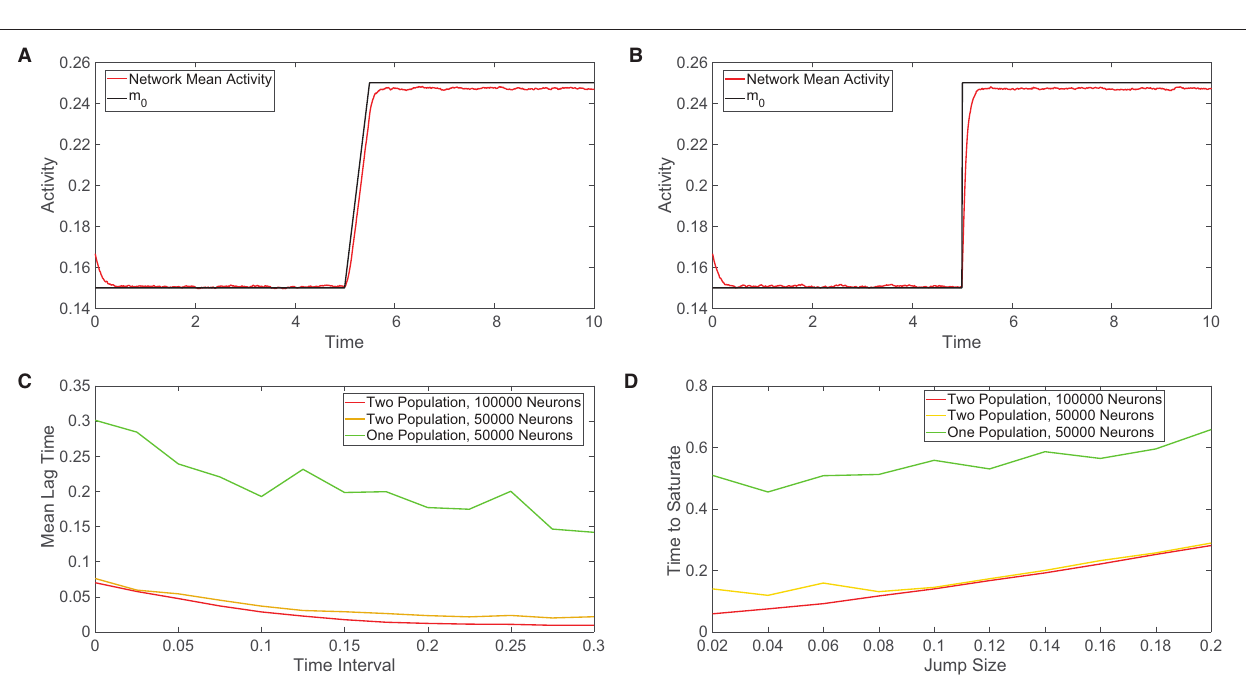
FIGURE 4 | and inhibitory inputs across each network model as a function of network size. (C) Variance of the ratio between time-averaged excitatory and inhibitory inputs across each network model as a function of network size. Parameters in the one-population network utilized are J E 1, J I 1.5, m 0 0.2, f E 0.5, K 0.08 N , and θ 0.7. Parameters in the two-population network utilized are = = = = = = J EE